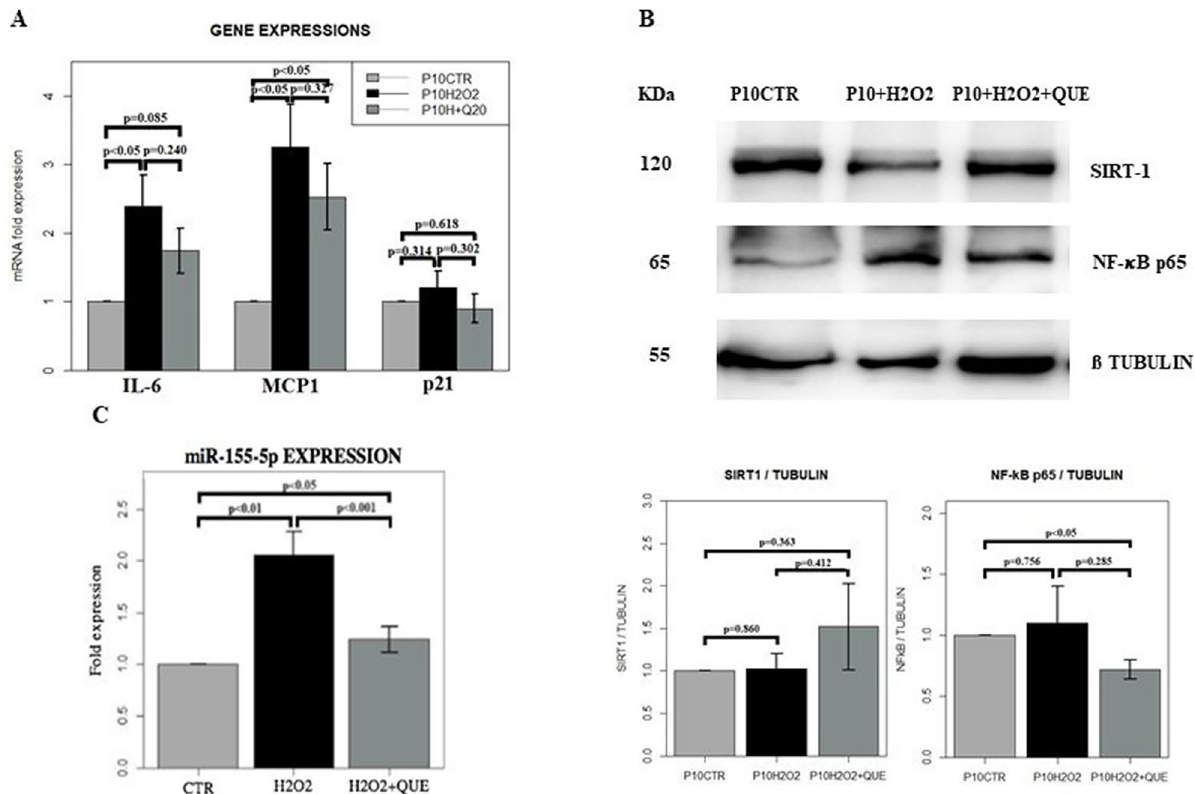
Figure 4. ( A ) Gene expression profile of adipocytes at PID10 (P10CTR), adipocytes at PID10 treated with H 2 O 2 (P10 + H2O2) and adipocytes at PID10 treated with H 2 O 2 plus quercetin (P10 + H2O2 + QUE). * p < 0.05, ** p < 0.01, *** p < 0.001. IL-6 = interleukin-6, MCP1 = monocyte chemoattractant protein 1, p21 = cyclin- dependent kinase inhibitor 1. ( B ) Cropped blots and densitometric analysis from western blotting assay of SIRT1 and NF-κB p65 normalized on β-tubulin, in adipocytes at PID10 (P10CTR), adipocytes at PID10 treated with H 2 O 2 (P10 + H2O2) and adipocytes at PID10 treated with H 2 O 2 plus quercetin (P10 + H2O2 + QUE). The values are represented as mean ± SE. SIRT1 = silent regulator information 1, NF-κB = nuclear factor kappa-light- chain-enhancer of activated B cells. For full length membranes please refer to Supplementary Fig. 2A, B. ( C ) Histograms showing the expression of miR-155-5p in adipocytes at PID10 (CTR), adipocytes at PID10 treated with H 2 O 2 (H2O2) and adipocytes at PID10 treated with H 2 O 2 plus quercetin (H2O2 + QUE). SIRT1 = silent regulator information 1, NF-κB = nuclear factor kappa-light-chain-enhancer of activated B